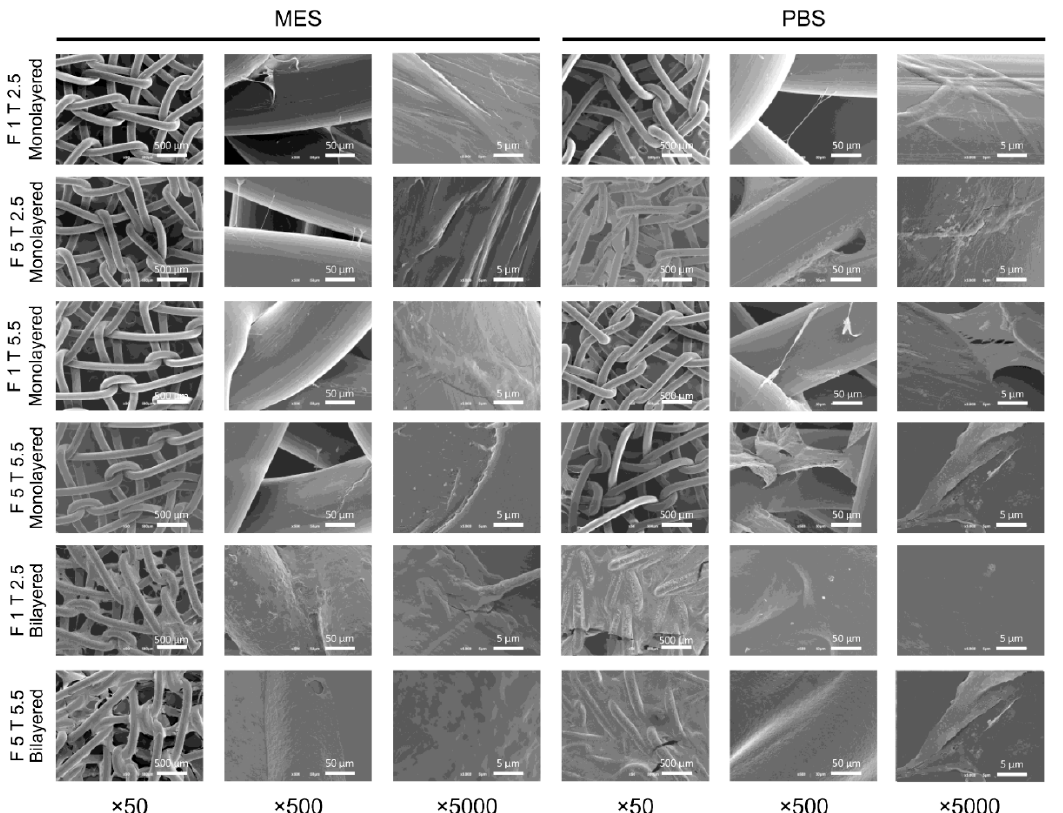
Figure 2. SEM micrographs of fibrin-coated surgical meshes without plasma treatment. Different combinations of fibrinogen (F) and thrombin (T) from Tisseel ® (Baxter) were diluted in MES or PBS and used to coat PP surgical meshes. × 50, × 500, and × 5000 magnifications are shown. Fibrinogen and thrombin concentrations are expressed in mg/mL and IU (international units)/mL, respectively. F 1: fibrinogen 1 mg/mL; F 5: fibrinogen 1 mg/mL; T 2.5: thrombin 2.5 IU/mL; T 5.5: thrombin 5.5 IU/mL.